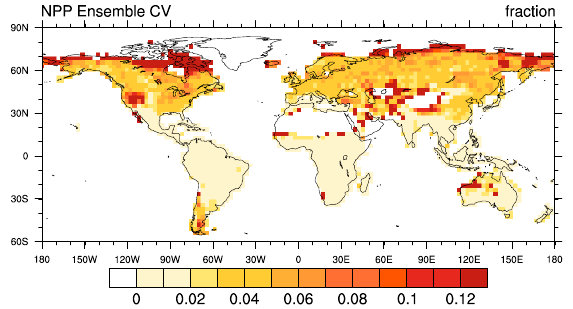
Fig. 12. Geographic pattern of the coefficient of variation of net primary productivity (NPP) across an ensemble of 20 JeDi-DGVM simulations, each with 2000 randomly sampled species ( S = 2000).